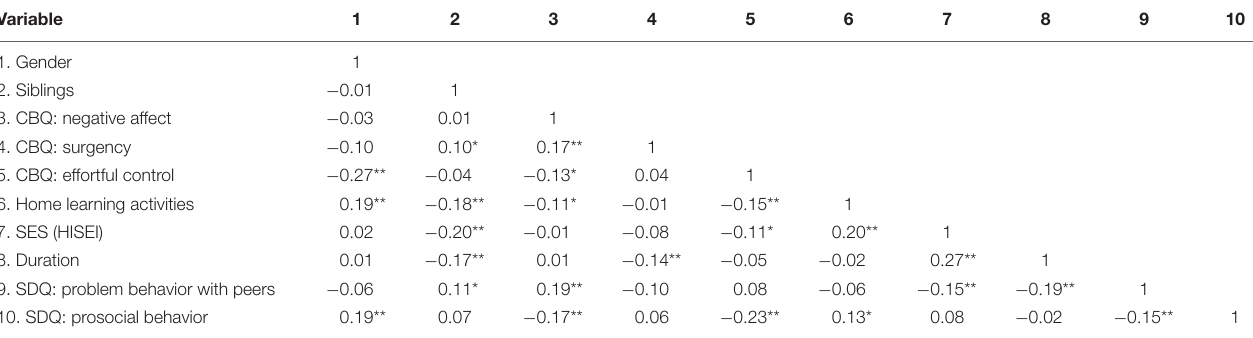
TABLE 5 | Bivariate correlations (two-tailed) of social competencies for children with a migration background.